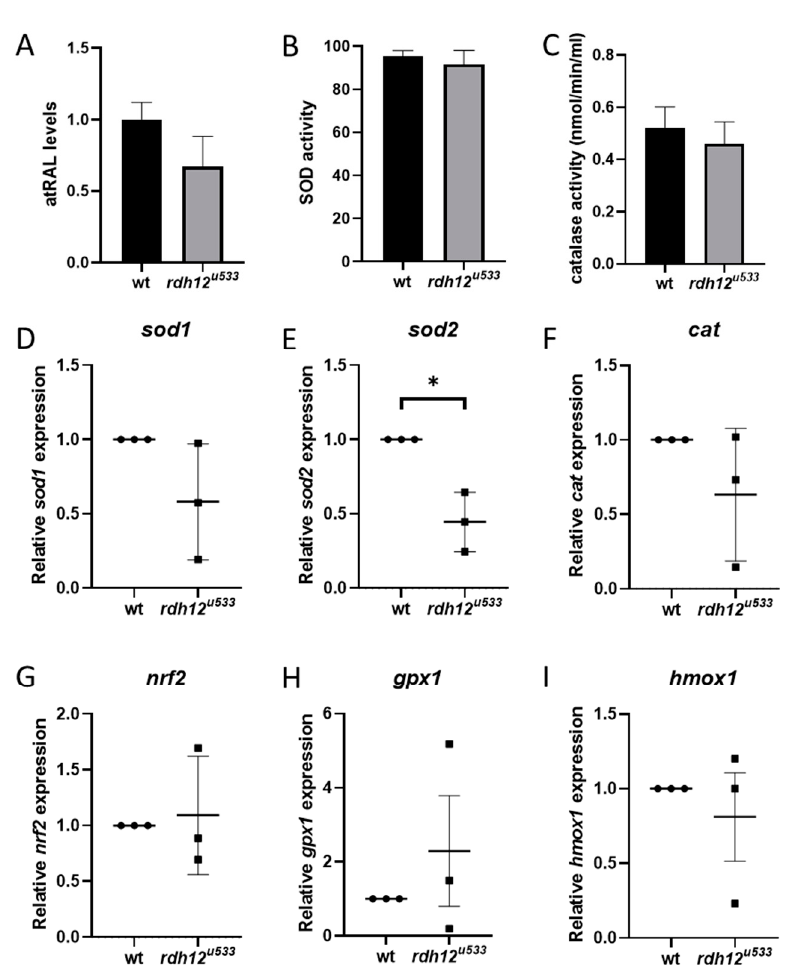
Figure 6. Analysis of oxidative stress in adult rdh12 u533 zebrafish retina. ( A ) atRAL levels in 16 mpf retina were analysed by HPLC. Activity of antioxidant enzymes SOD ( B ) and CAT ( C ) was analysed in 16 mpf retina, but no significant differences were found between wt and rdh12 u533 mutant fish. ( D – I ) Expression of oxidative stress markers was analysed by RT-qPCR in retinas from wt and rdh12 u533 fish at 12 mpf. mRNA expression of sod2 was significantly reduced in rdh12 u533 fish retinas. Data are expressed as mean ± SEM; * p < 0.05.